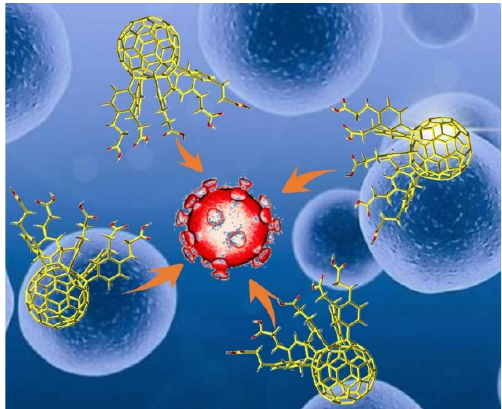
Figure 1. Possible interaction between fullerene molecules and coronavirus, in which fullerene molecules inhibit virus replication.